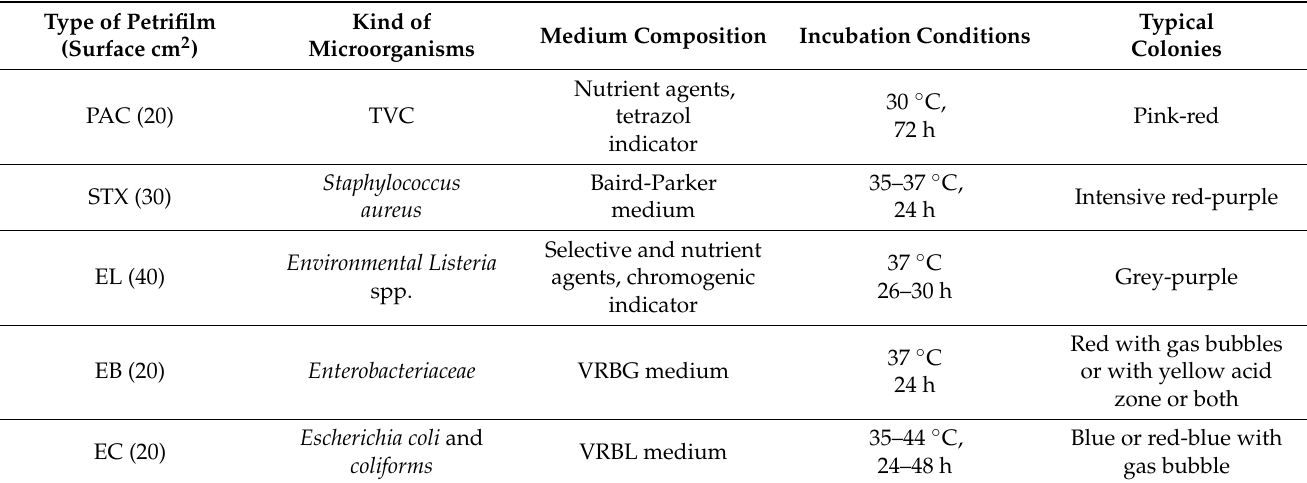
Table 2. Kinds and characteristics of contact plate method